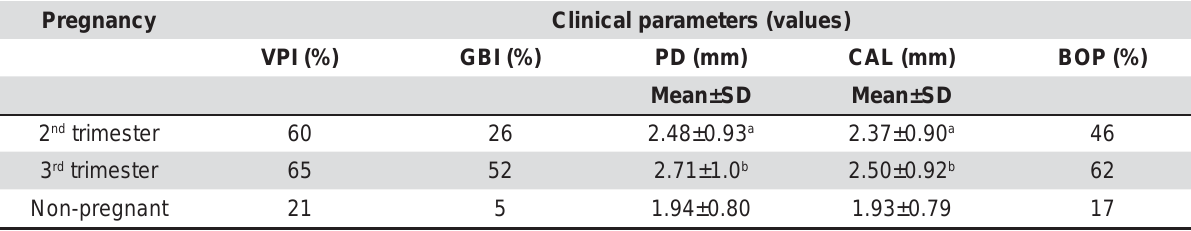
Table 1- Periodontal conditions of women at the 2 nd and 3 rd trimesters of pregnancy Pregnancy